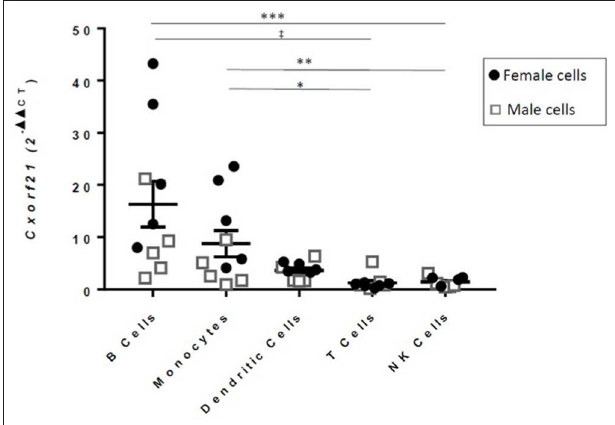
FIGURE 1 | RT-qPCR of CXorf21 from primary monocytes, dendritic cells, natural killer cells, B cells, and T cells of healthy male and female controls [12; females = 6 (black circles)/males = 6 (gray squares)]. One-way ANOVA Kruskal-Wallis non-parametric test with a Dunn’s multiple comparisons. * p < 0.05; ** p < 0.01; *** p < 0.001, ‡ p < 0.0001. Error bars represent